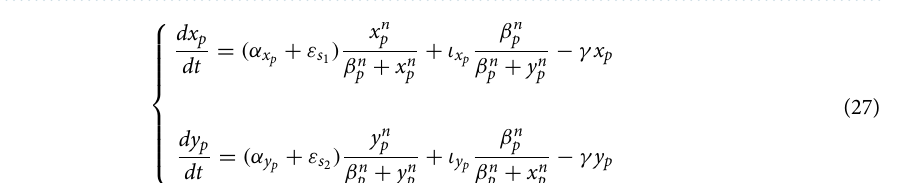
Figure 2. Hypothetical dish as a main scene for our system dynamics, and the filters representation for scoring algorithm. ( a ) the hypothetical dish is occupied with four types of cells, S (cyan), P (green), A (yellow), and B (red). Yellow, and red triangles represent signalling molecules namely, S 1 , and S 2 , produced by cell types A and B , respectively. ( b , c ) Filters representing template, and penalty matrices corresponding to the perfect borders of the population initial pattern and the valid territory of the entire dish,